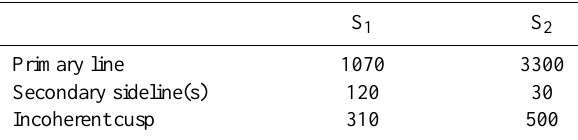
Table 3. Integrated energy in tidal bands, Pa 2 S 1 S 2 Primary line 1070 3300